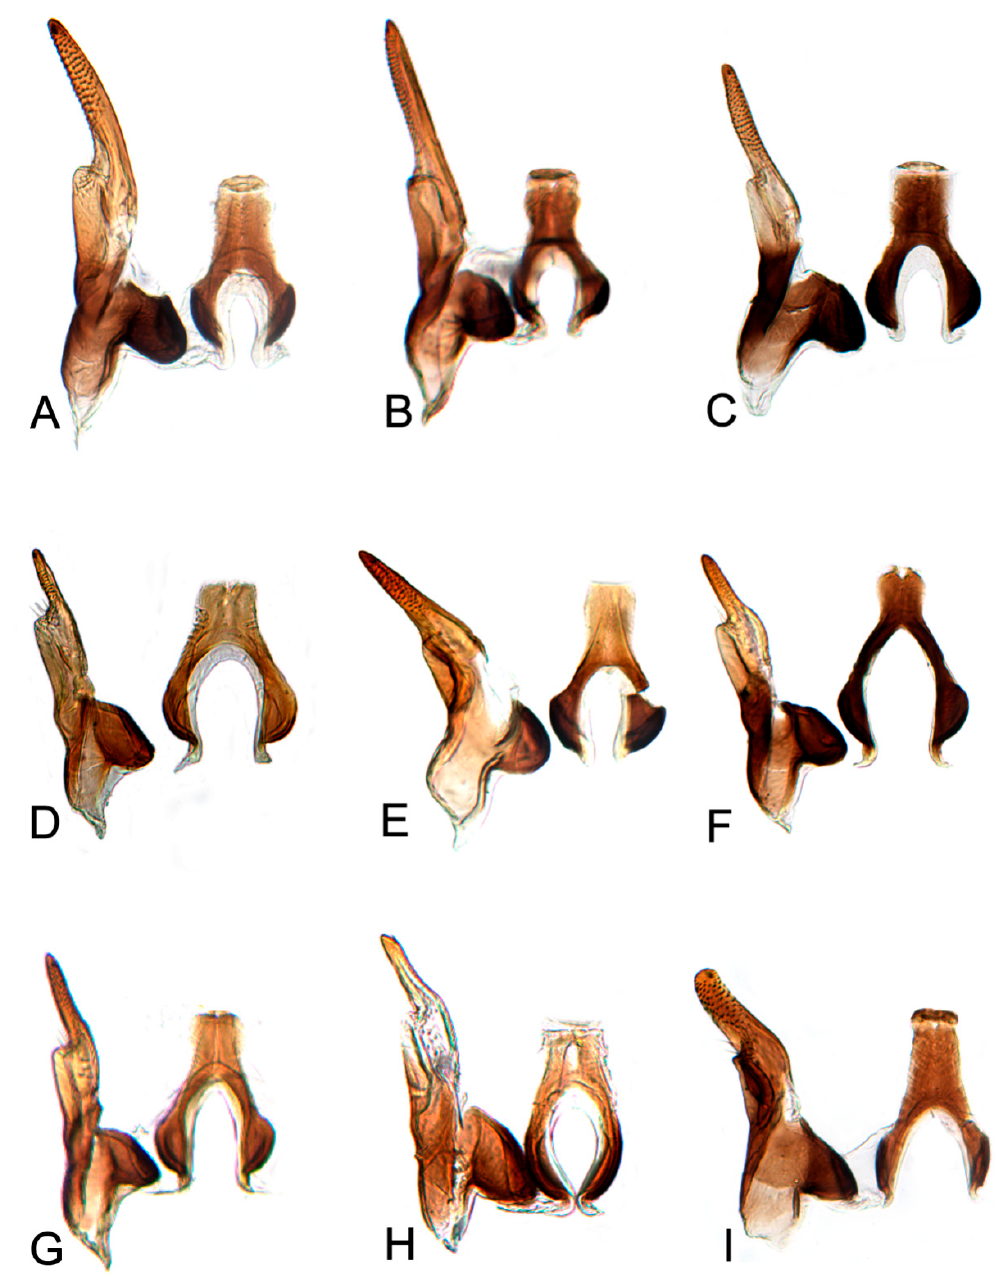
Figure 14. Style and connective, ventral view. ( A ) H. prolongatus ; ( B ) H. spiniferous ; ( C ) H. kuohi ; ( D ) H. tortuosus ; ( E ) H. aberrans ; ( F ) H. knightiellus ; ( G ) H. tenuis ; ( H ) H. subtilis ; and ( I ) H. di ff ractus .